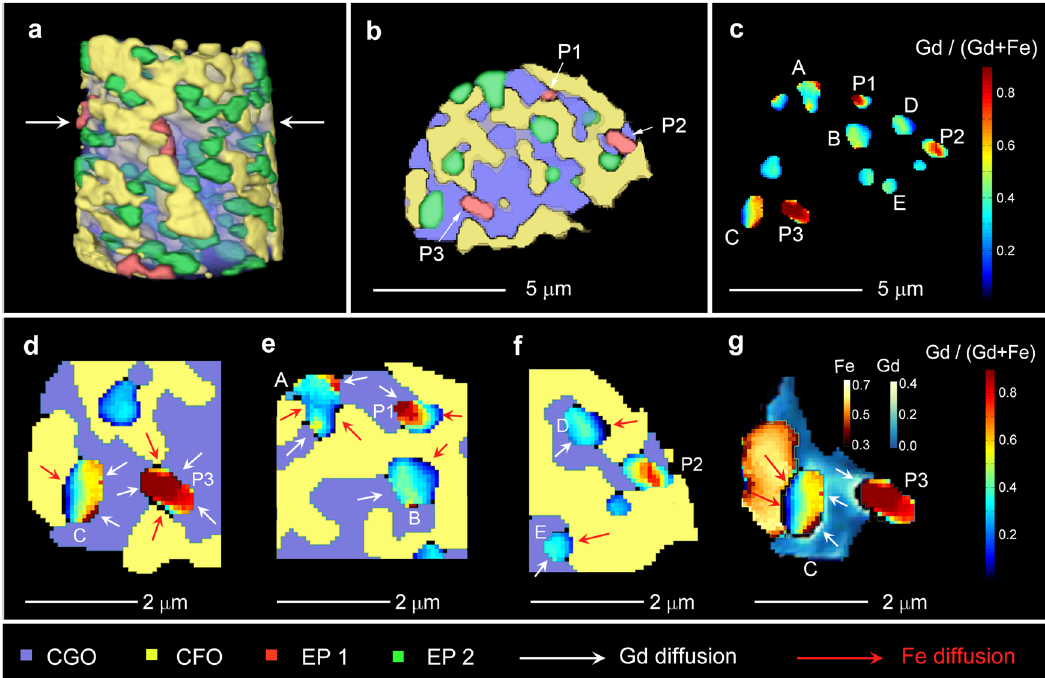
Fig. 3 Visualization of four material phases (CGO, CFO, EP1, and EP2). a 3D view of segmented phases. b 2D cross-sectional slice through the two arrows shown in a . c Emergent phases with a grayscale map of Gd/(Gd + Fe) corresponding to the cross-sectional slice in b . Note that some grains such as P1 and C exhibit dramatic concentration gradients. d – f Enlarged grayscale map of Gd/(Gd + Fe) around EP1 and EP2 grains. White and red arrows indicate the diffusion path for Gd and Fe from the neighboring CGO and CFO phases to emergent phases, EP1 and EP2. g Grayscale concentration map of Gd/(Gd + Fe) in the parent phases (CGO and CFO) adjacent to the emergent phase grain C and P3. The Fe color map indicates the Fe concentration in CFO, and the Gd color map shows the Gd concentration in CGO. The parent phases also show higher Gd and Fe local concentrations in the interfacial regions, as indicated by the red and white arrows. Note that for d – g , the “ rainbow ” color scheme adapted from c applies to EP1 and EP2 particles